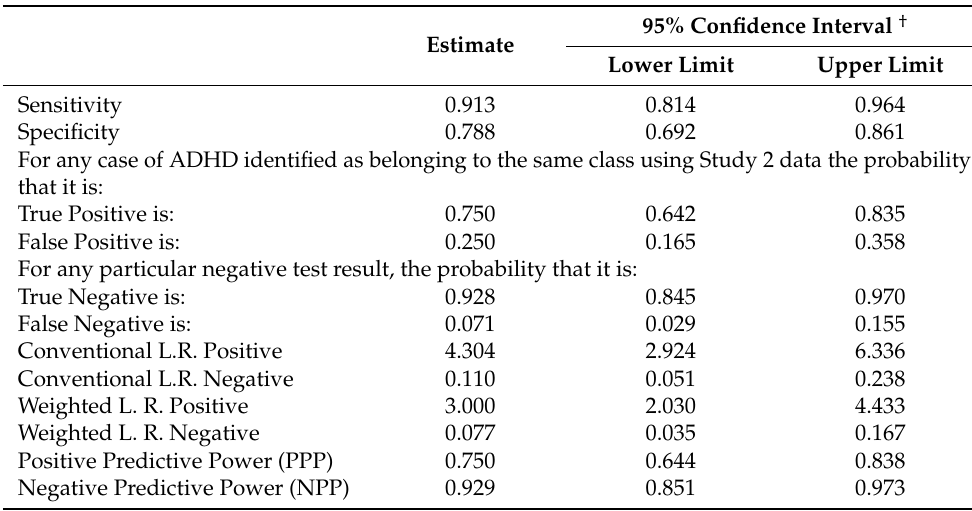
Table 4. Indices of sensitivity and specificity for agreement between latent classes of Study 1 and 2. 95% Confidence Interval † Estimate Lower Limit Upper Limit Sensitivity 0.913 0.814